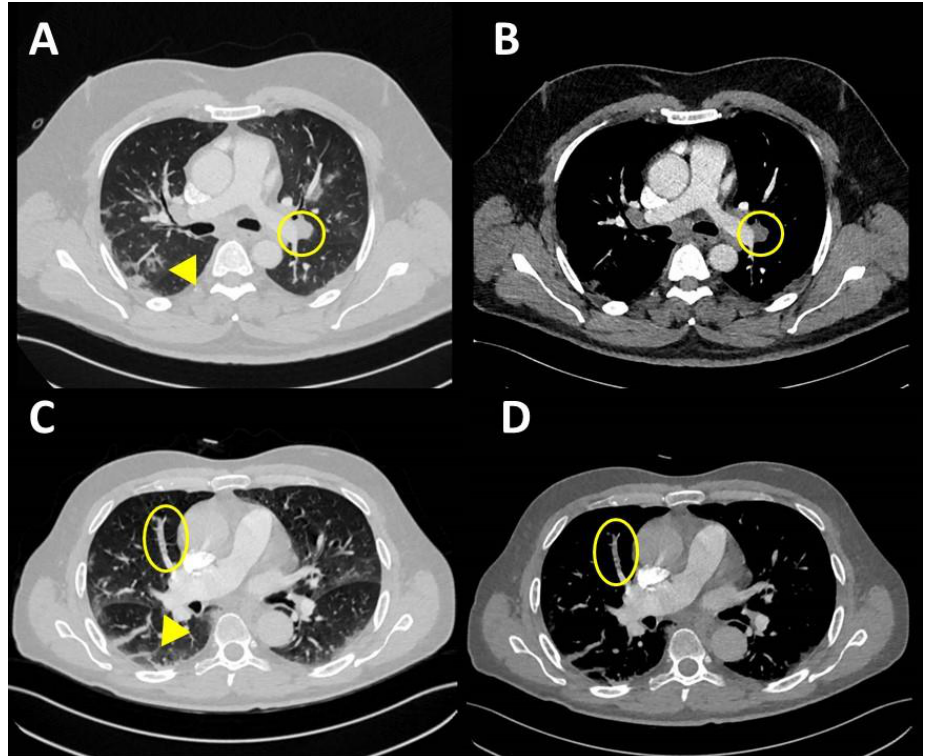
Figure 5. CT scan is able to identify both gross pulmonary embolism ( A , B ) and tinier obstructions in subsegmental artery ( C , D ). Embolism (Circles) is not related to site of pneumonia but to endotheliitis and not to pulmonary inflammation